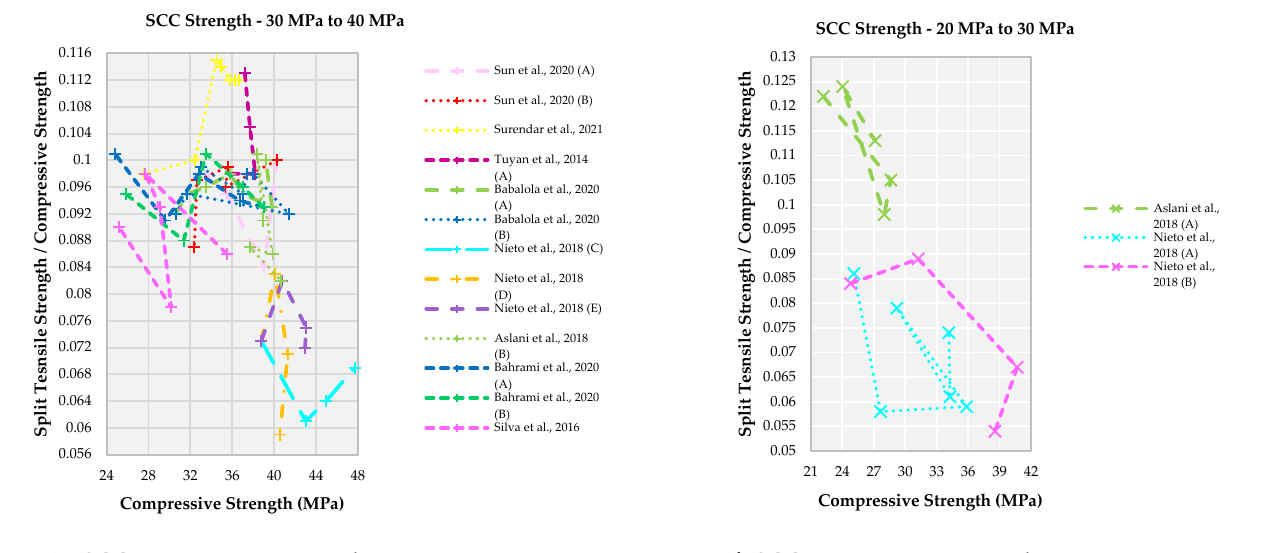
Figure 2. Relationship between ratio of split tensile strength to compressive strength and compressive strength according to literature for SCC recycled aggregate concrete.